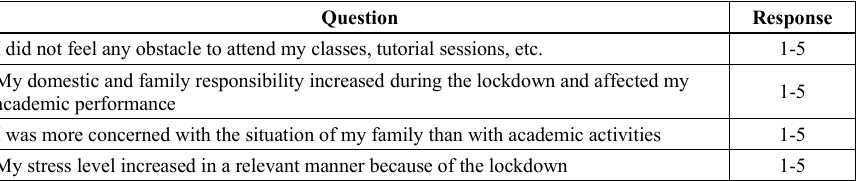
Table 3. Students’ survey